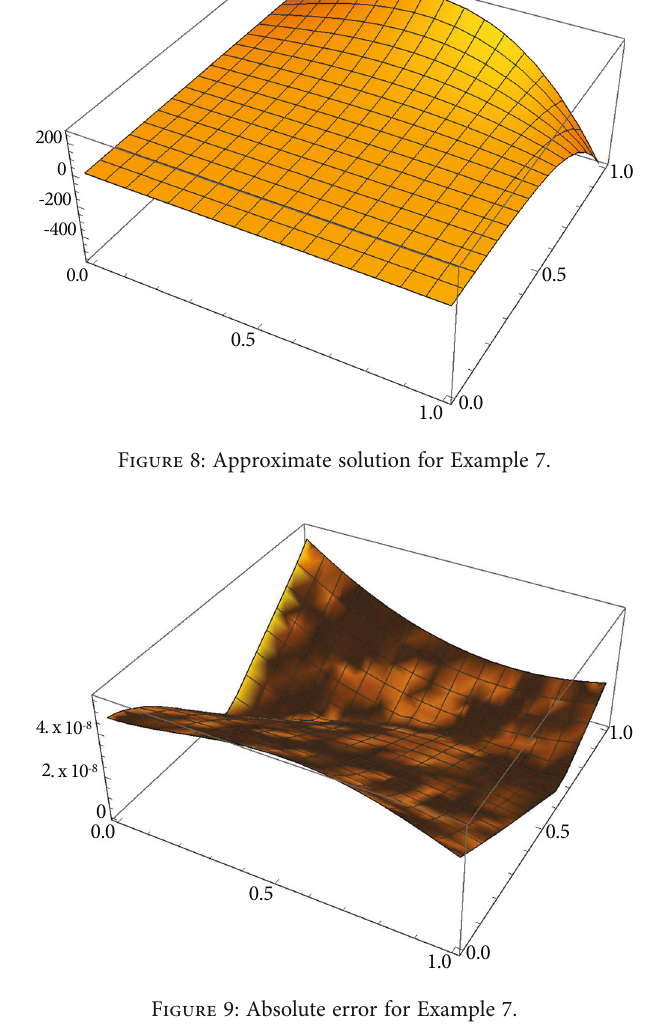
Figure 11: Approximate solution for Example 8.